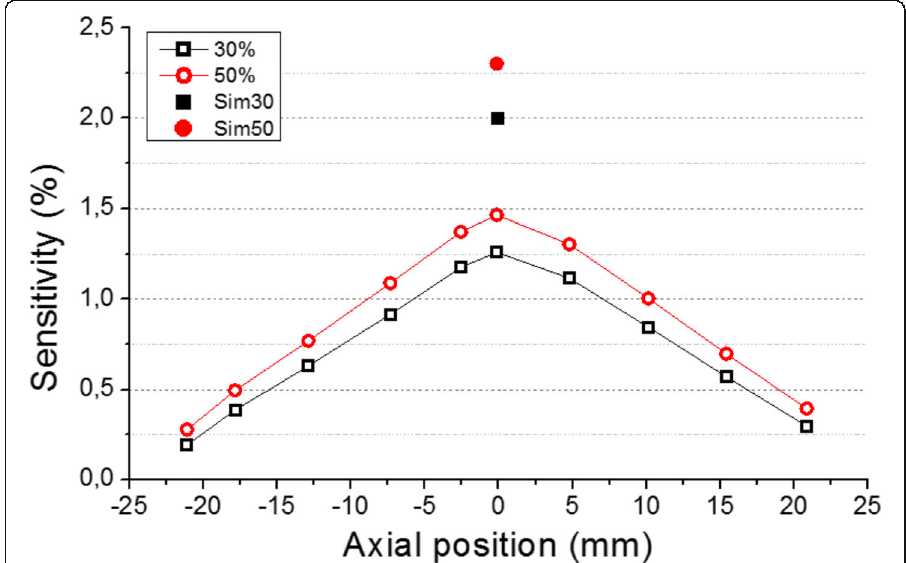
Fig. 10 Sensitivity (%) curves for two energy windows 30% (black open squares) and 50% (red open circles), respectively, as a function of the reconstructed source position. The solid black square and red circle exhibit the simulated sensitivity for the 30% and 50% energy windows, respectively